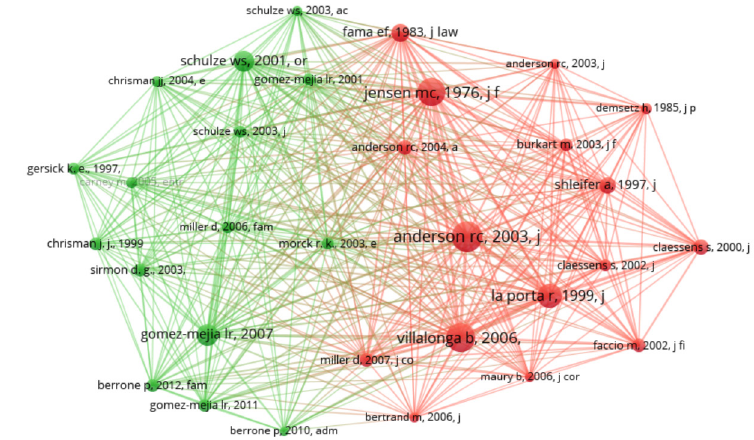
Figure 10. The reference co-citation